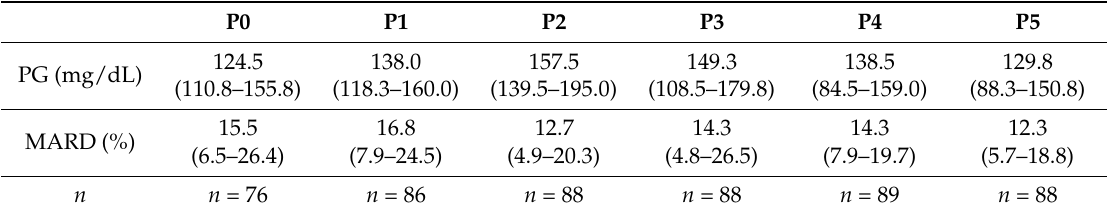
Figure 3. PG and CGM measurements from P0 to P5 for anaerobic sessions. Data shown are mean ± SD. PG is denoted by the black solid line and black-shaded area. CGM is denoted by the blue solid line and blue-shaded area. The vertical dashed line indicates the start of the anaerobic exercise sessions. PG, plasma glucose; CGM, continuous glucose monitor; SD, standard deviation. Table 4. Values of PG and accuracy of CGM for anaerobic exercise sessions.